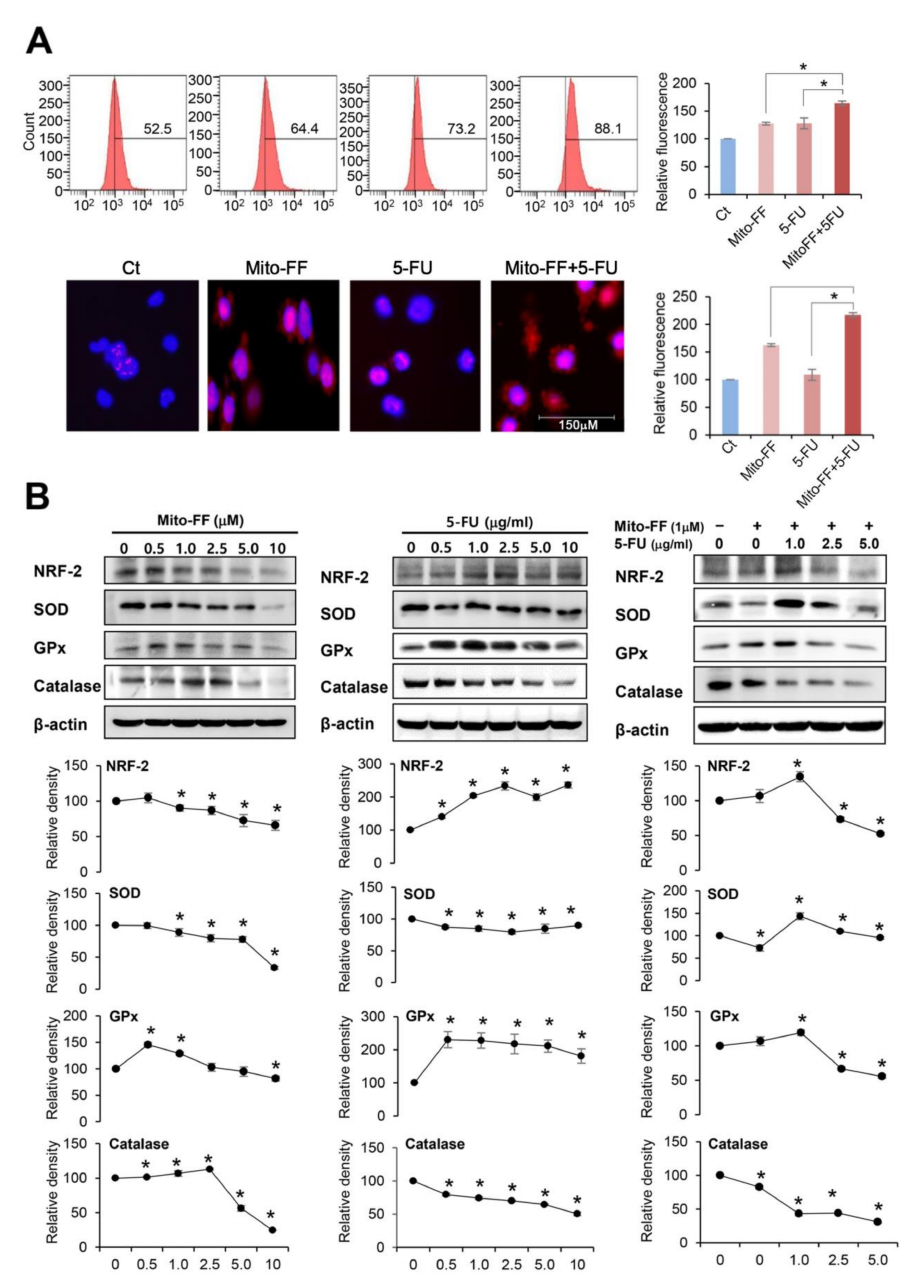
Figure 3. Anticancer activities of each treatment in relation with oxidative stress. ( A ) [Top] Estimation of superoxide levels in AGS cells by MitoSOX-based flow cytometric assay. [Bottom] Quantification of superoxide levels in AGS cells as determined by MitoSOX immunostaining (red signal). Collectively, combination therapy significantly enhanced the intensity of fluorescence of the AGS cells to bright red far more than monotherapy, suggesting the superiority of combination therapy over monotherapy in promoting mitochondrial superoxide synthesis. ( B ) Western blot analysis to determine the changes of NRF-2 and antioxidant enzymes (superoxide dismutase (SOD), glutathione peroxidase (GPx), and catalase) according to mono- and combination therapy using 5-FU and Mito-FF in AGS cells. As the concentrations were increased, monotherapy (either 5-FU or Mito-FF) led to the reduced expression of NRF-2 and antioxidant enzymes. Moreover, combination therapy induced the most prominent reduction of expression in these markers. Values are presented as mean ± standard deviation of three independent experiments. * P <